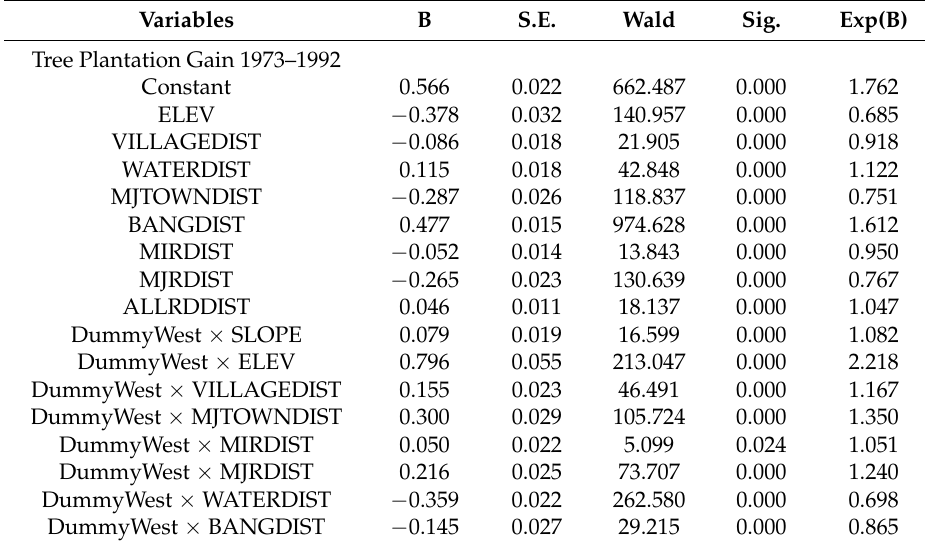
Table A2. Logistic regression parameters estimated from tree plantation